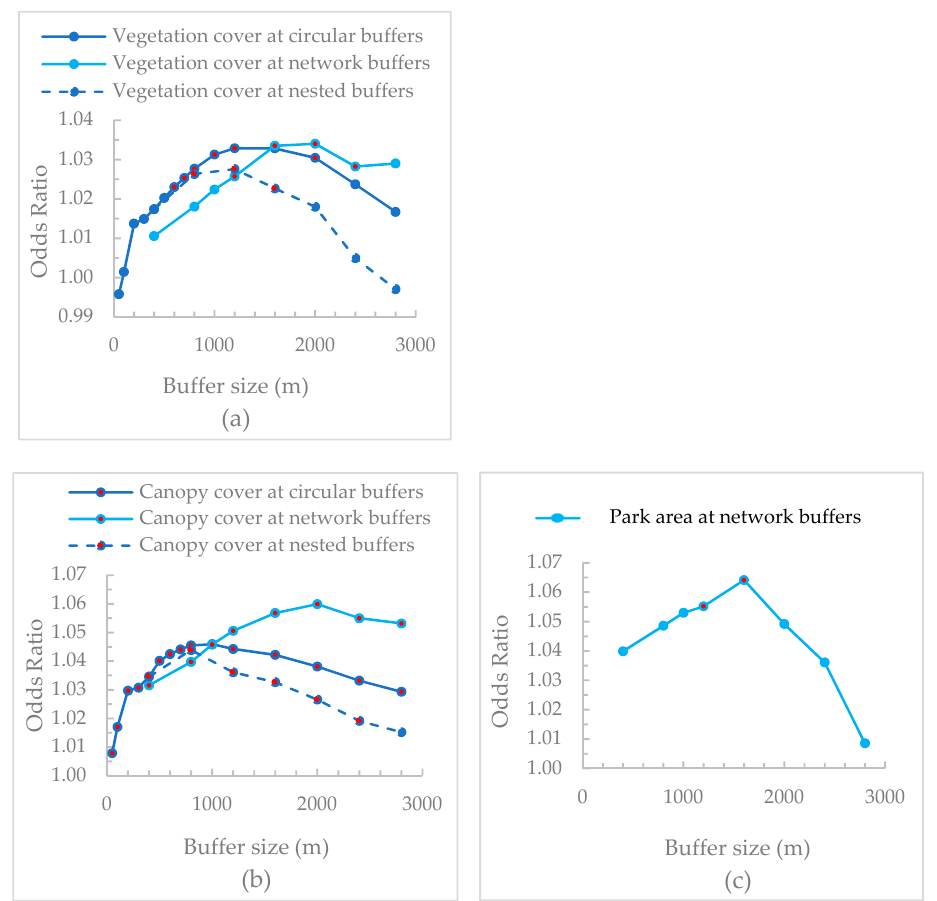
Figure 5. The associations of ( a ) vegetation cover, ( b ) canopy cover, and ( c ) park area with mental health at different buffers (red dots are significant results at the significant level of 0.05).